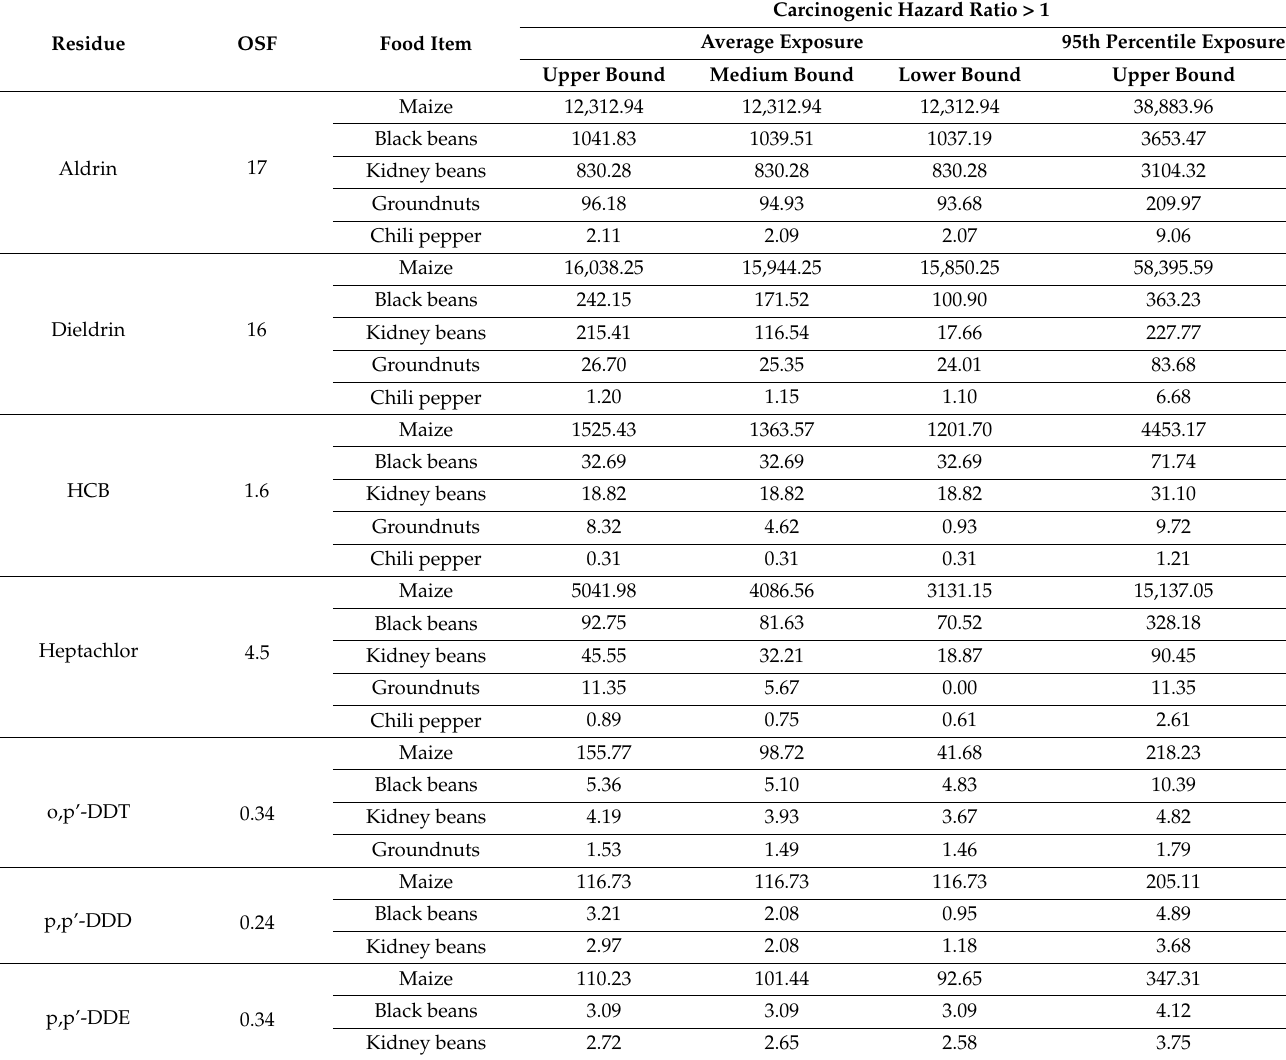
Table 3. Carcinogenic hazard ratio with values greater than 1 from risk assessment of 9 pesticide residues in 11 food items collected in the 3 largest cities of